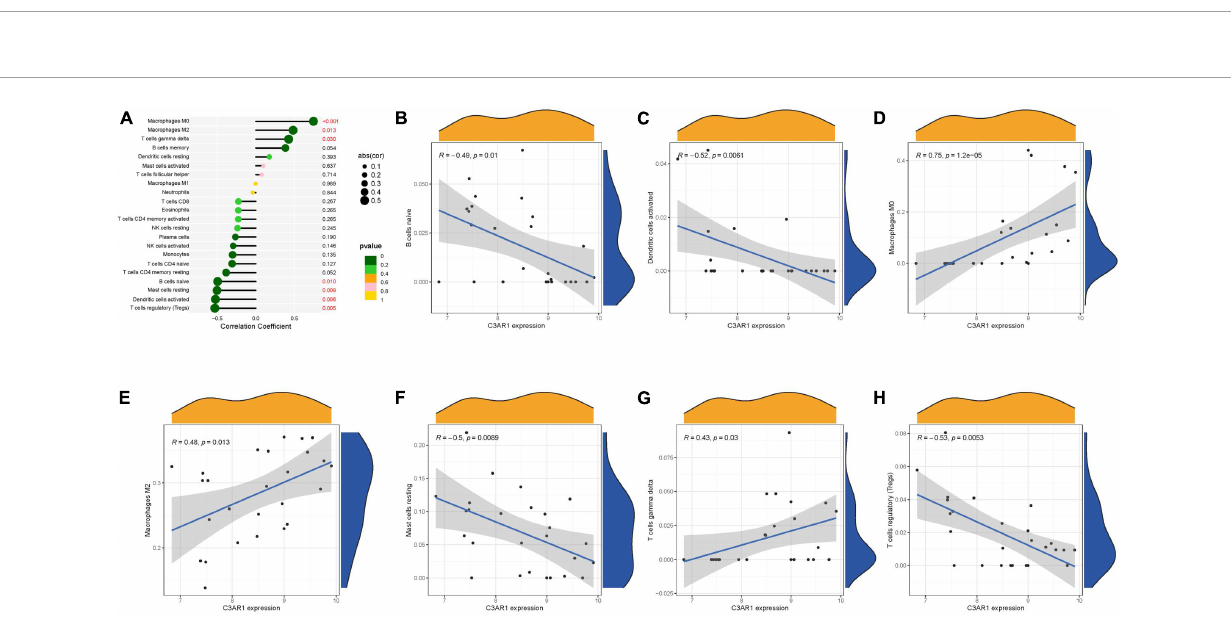
FIGURE7 Immune correlation analysis of C3AR1. (A) Immune correlation lollipop chart. (B–H) Immune cells and C3AR1 correlation scatter